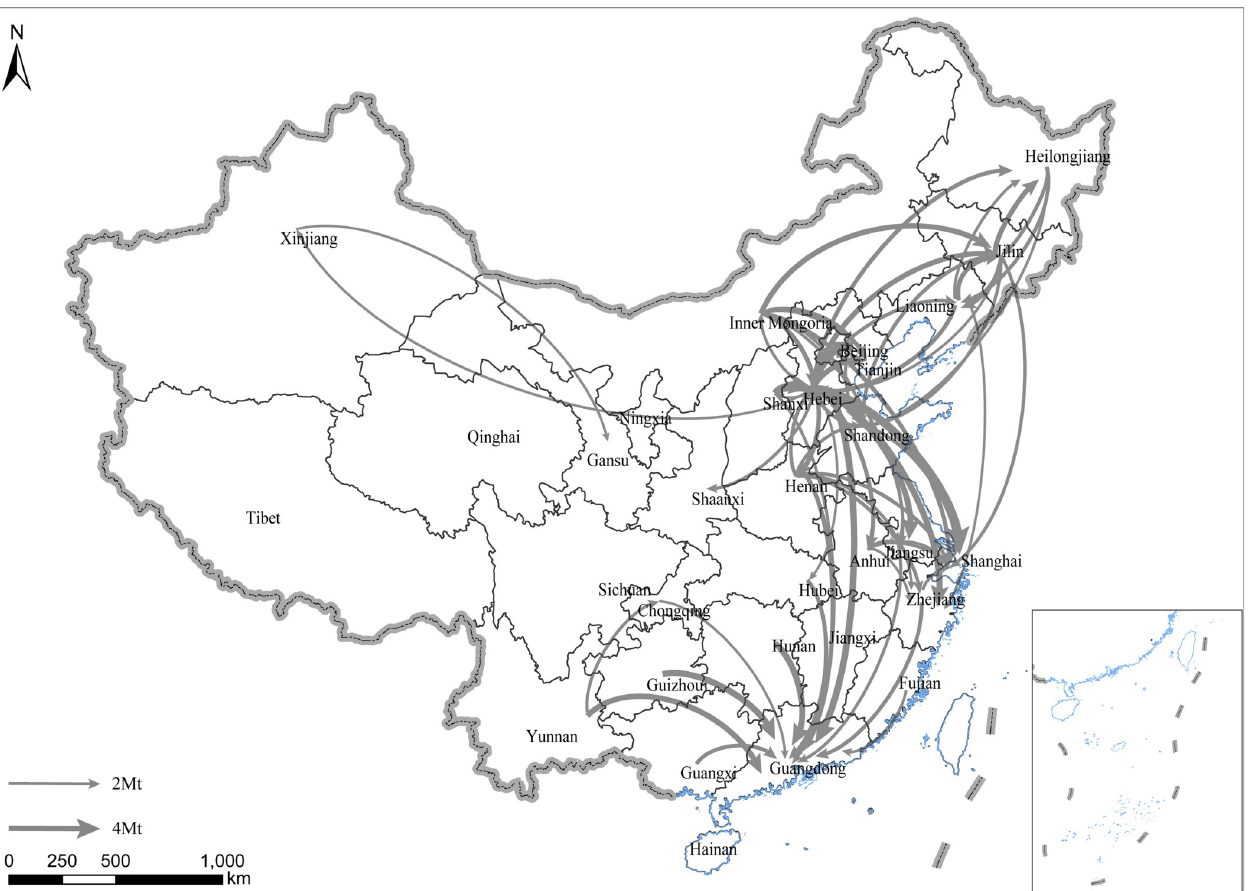
Fig 1. Interprovincial embodied CO 2 flow of China in 2007. Only flows exceeding 2 Mt are included. The arrow indicates the direction of each flow. The width of the flows indicates the amount. Republished from standard map service of NGCC [28] under a CC BY license, with permission from Chinese National Basic Geographic Information Center, original copyright 2020. Note: The base map of Figs 1–3 is from the website "http://bzdt.ch.mnr.gov.cn/", which is run under National Geomatics Center of China (NGCC) for public use. It is an open access website in need of no permission for publication.